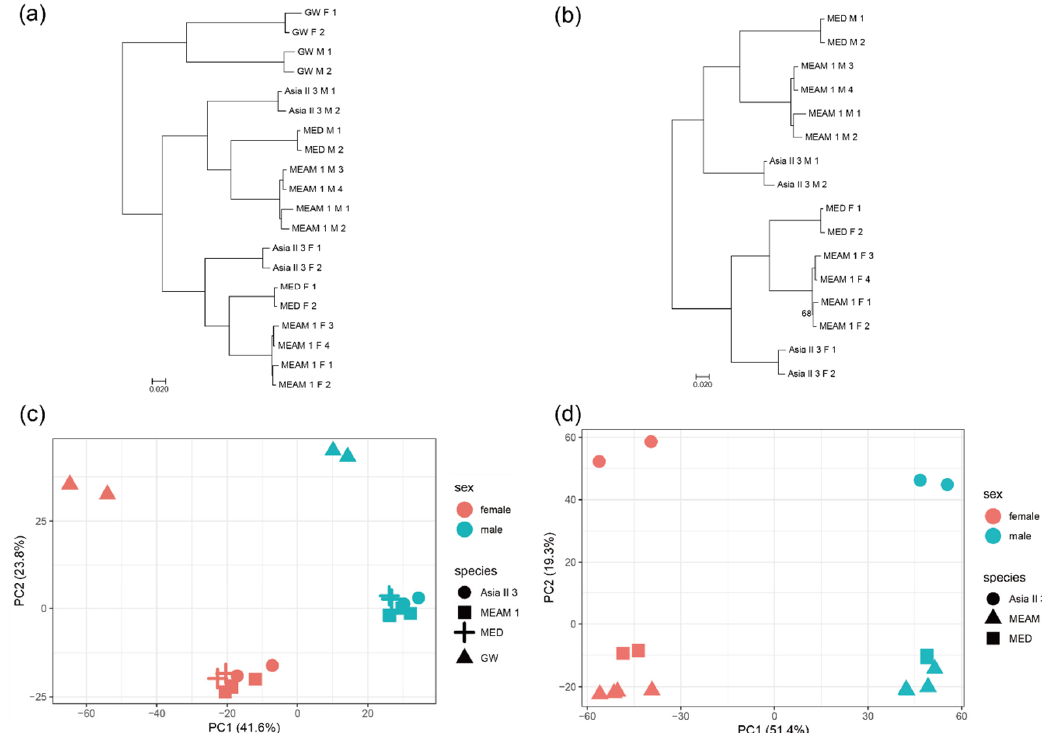
Figure 1. Global patterns of gene expression variation across species and sexes. Phylogeny trees of gene expression based on pairwise distance matrices (1- ρ , ρ is Spearman’s correlation coe ffi cient) built by the balanced fastME method across the three Bemisia species and the outgroup greenhouse whitefly (GW) ( a ) and across the three Bemisia species ( b ) (F = female; M = male). In the nodes of phylogenetic trees, only the bootstrap values less than 90 were labeled. Phylogeny trees built by the neighbor-joining (NJ) method are presented in Figure S1. Results of the principal component analysis of gene expression across the three Bemisia species and greenhouse whitefly ( c ) and across the three Bemisia species ( d ).